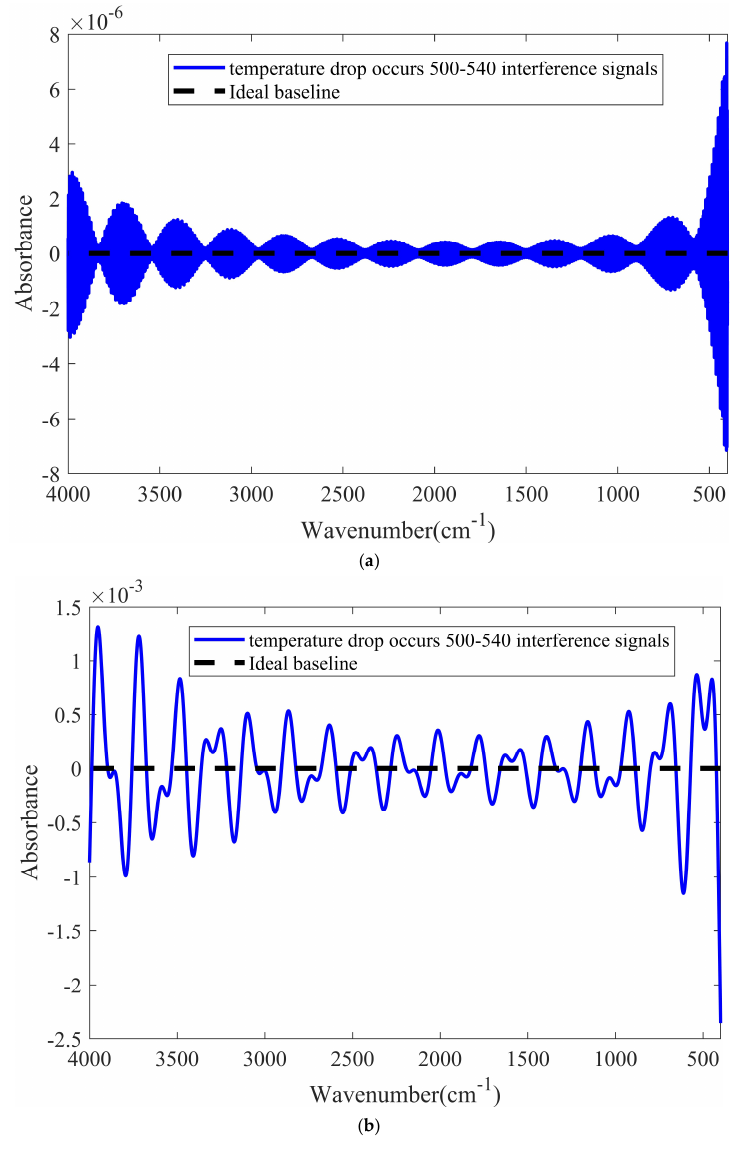
Figure 2. Simulated baselines with the light source temperature decreasing for a short time. ( a ) The temperature drop of the light source occurs far from zero optical path difference. ( b ) The temperature drop of the light source occurs near the zero optical path difference.